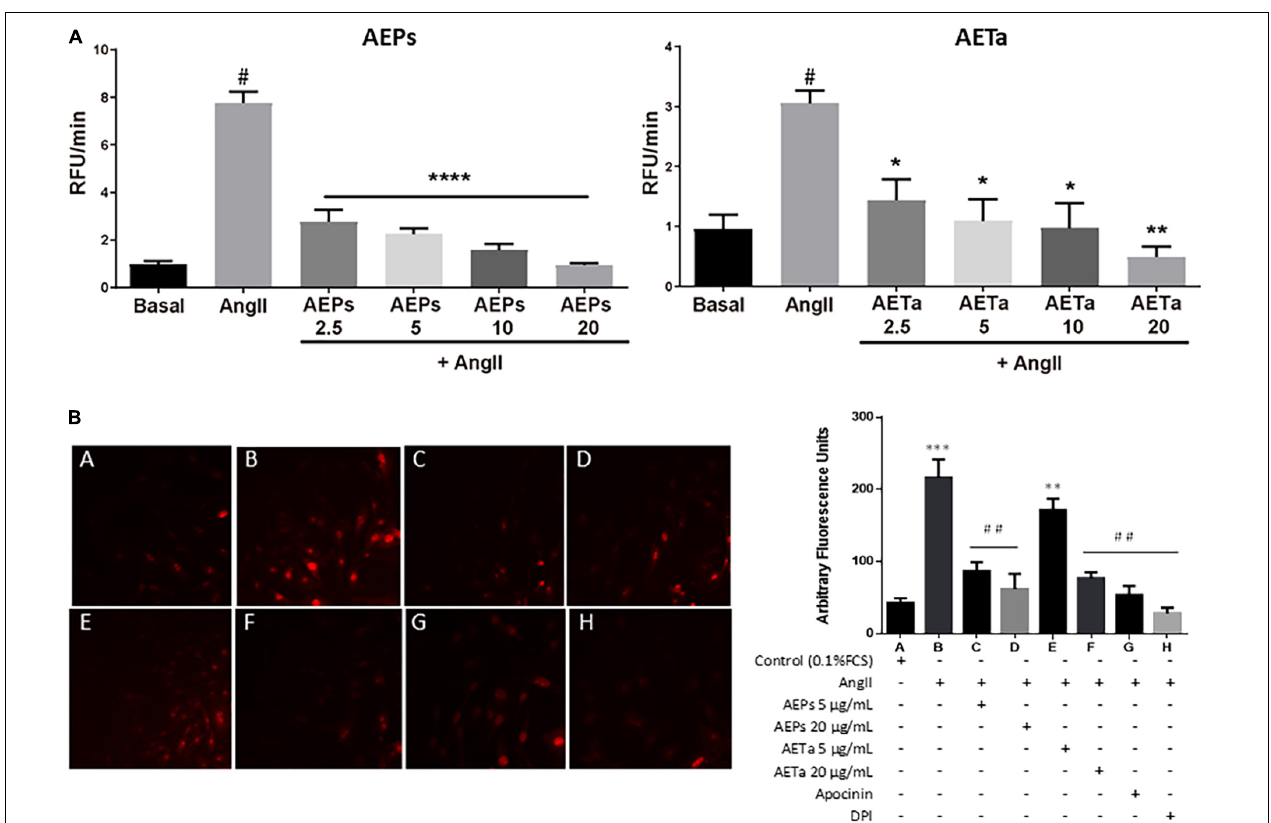
FIGURE 3 | Effect of Prosopis strombulifera and Tessaria absinthioides on angiotensin II-induce ROS generation. (A) VSMC were pre-exposed to 0, 2.5, 5, 10, or 20 µ g/ml of either AEPs or AETa, during 1 h prior to AngII (100 nM) addition. Results are presented as the AngII-induced changes in CM-H 2 DCFDA fluorescence after 40 min, calculated as the difference between the stimulated response and the basal value. (B) Intracellular superoxide anion generation: VSMC culture in 0.1% FCS (control A) or treated with AngII (100 nM) alone (B) or with AEPs 5 µ g/ml (C) and 20 µ g/ml (D); AETa 5 µ g/ml (E) and 20 µ g/ml (F); apocynin (G), or DPI (H); and stained with dihydroethidium (DHE). Red color fluorescence due to oxidant stress was observed using a fluorescent microscope as described in section “Materials and Methods.” Data are shown as the mean ± SEM of 3 independent experiments. * p ≤ 0.05, ** p ≤ 0.01, *** p ≤ 0.001, **** p ≤ 0.0001 vs Control; # p ≤ 0.01, ## p ≤ 0.001 vs Ang II. ROS, reactive oxygen species; VSMC, vascular smooth muscle cell; FCS, fetal calf serum; AEPs, aqueous extract of P. strombulifera ; AETa, aqueous extract of T. absinthioides ; DPI, diphenylene iodonium chloride.